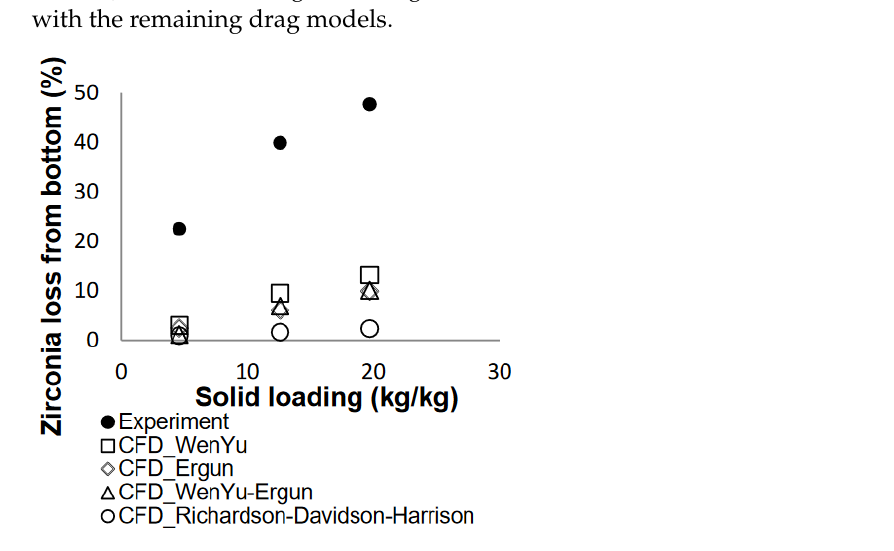
Figure 8. Zirconia particles exit from the bottom when only zirconia particles are fed to the classifier.